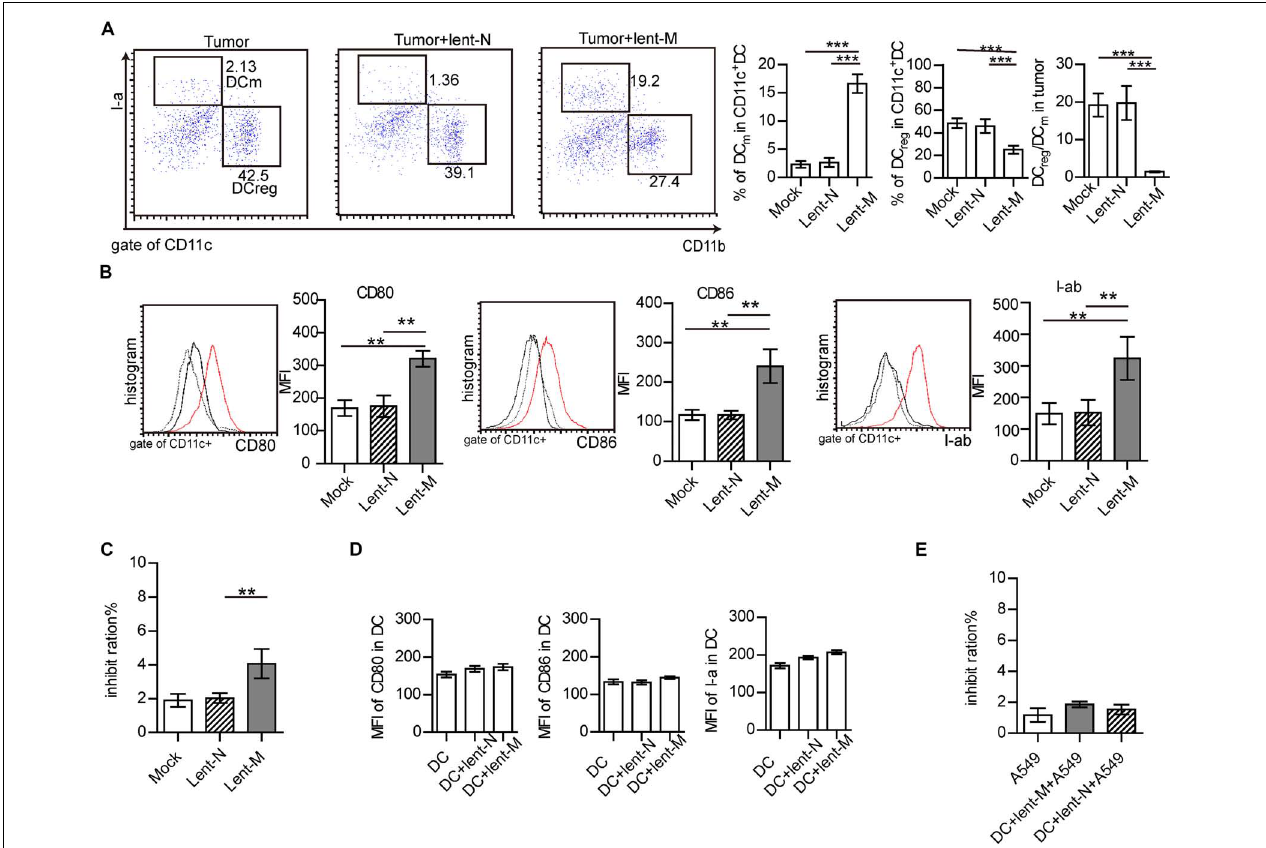
FIGURE 3 | MiR-138-5p treatment changed the statues of DCs in tumor. (A) The percentage of mature DCs (DC m ), regulatory DCs (DC reg ) and the ratios of regulator DCs to mature DCs (DC reg /DC m ) in tumors from A549 bearing mice, which were treated with lent-miR-138 (Tumor + lent-M) or lent-NC (Tumor + lent-N) or not (Tumor). (B) The expression levels of CD80, CD86 and I-Ab on tumor infiltrating DCs from lent-M, lent-N treated A549 bearing mice or not. (C) The inhibit ration of tumor infiltrating DCs from lent-M, lent-N treated A549 bearing mice or not (mock). Tumor infiltrating DCs were isolated from every group and incubated with A549 cells for 24 h, and the apoptosis ratio of A549 cells was analyzed by flow cytometry. (D) With lent-M/lent-N treatment or not, the expression of CD80, CD86, and I-ab on isolated DCs cells. There are no significantly different between every group. (E) With lent-M, lent-N treatment, the inhibit ration of DCs on A549 cells were analyzed. There are no significantly different between every group. (** P < 0.01, *** P < 0.001).